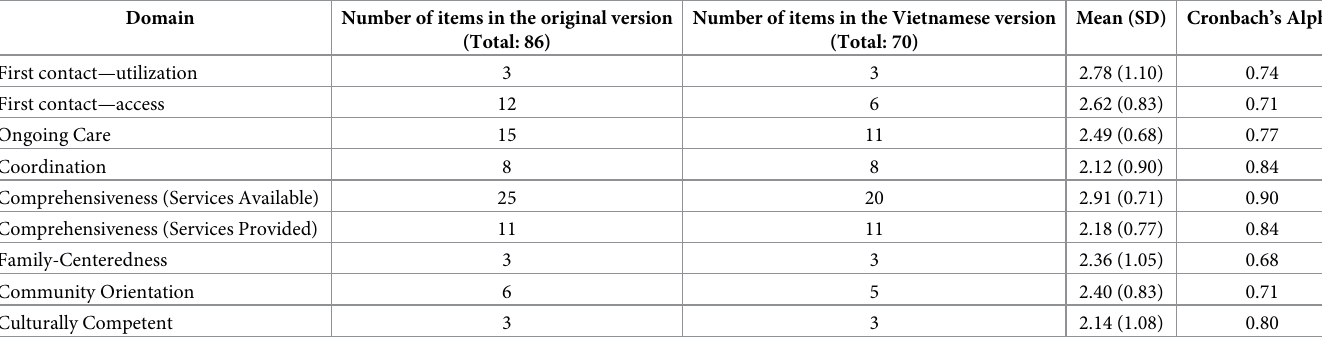
Table 4. Descriptive statistics of the domains